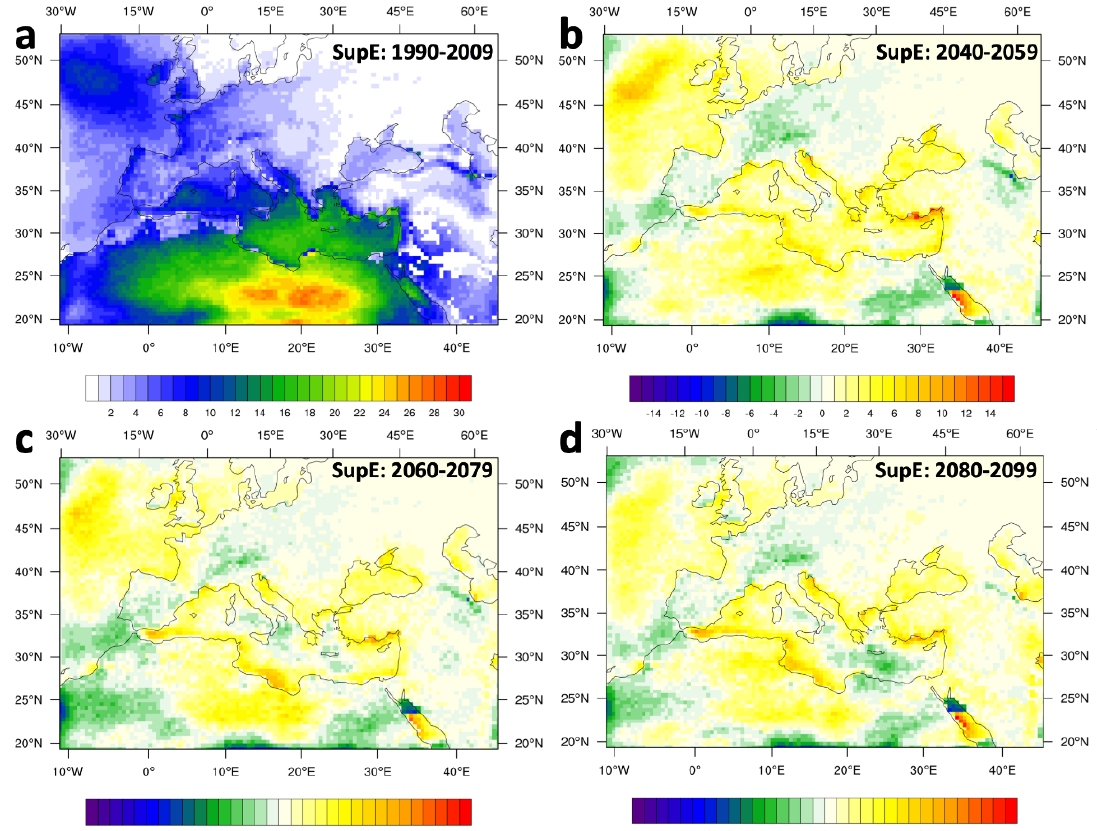
Figure 5. ( a ) Annual average number of days with CAPE ≥ 100 J / kg AND 0–6 km SHEAR ≥ 20 m / s (SupE) for 1990–2009, ( b ) changes in average number of days with SupE for 2040–2059, ( c ) changes in average number of days with SupE for 2060–2079, ( d ) changes in average number of days with SupE for 2080–2099.